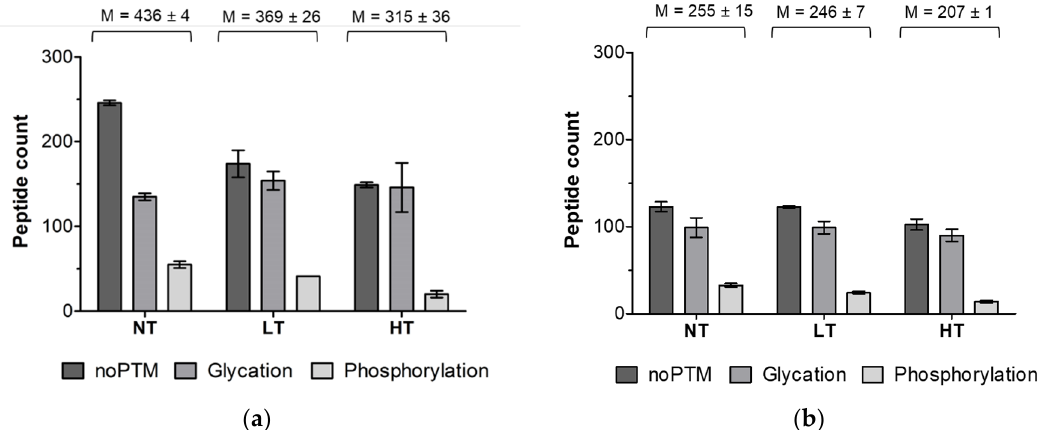
Figure 1. Total count of non-modified, glycated and phosphorylated digestion-derived peptides derived from cow’s milk protein. Samples were non-treated (NT), heated at low temperatures (LT), and heated at high temperature (HT) ( a ) after 10 min in the intestinal phase and ( b ) after 60 min in the intestinal phase. Number of peptides without post translational modification (noPTM), glycated, and phosphorylated peptides were compared. The minimum length for identification was eight amino acids. Error bars represent the standard deviation of duplicate digestions. The mean (M) of the total count of peptides per treatment and digestion time point ± standard deviation for duplicate digestions is shown above the bars.